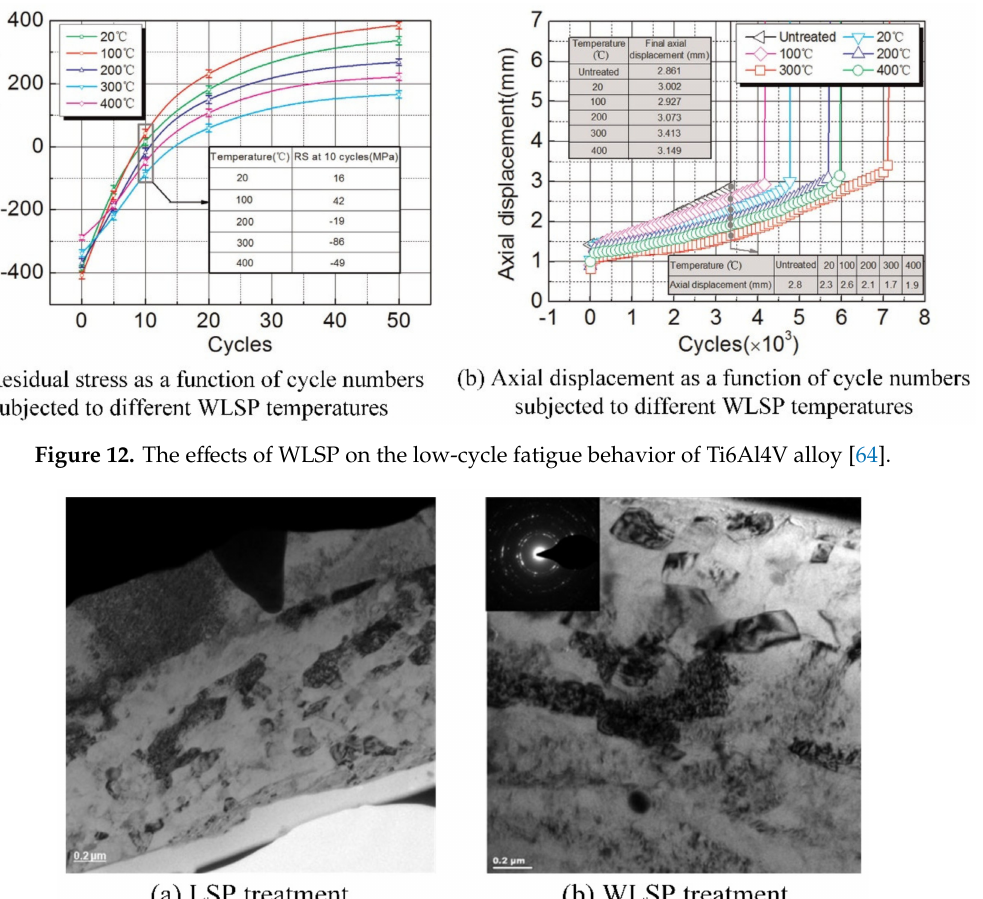
Figure 11. The enhanced residual stress by WLSP: ( a ) AA7075, ( b ) AA6160 [62,63].